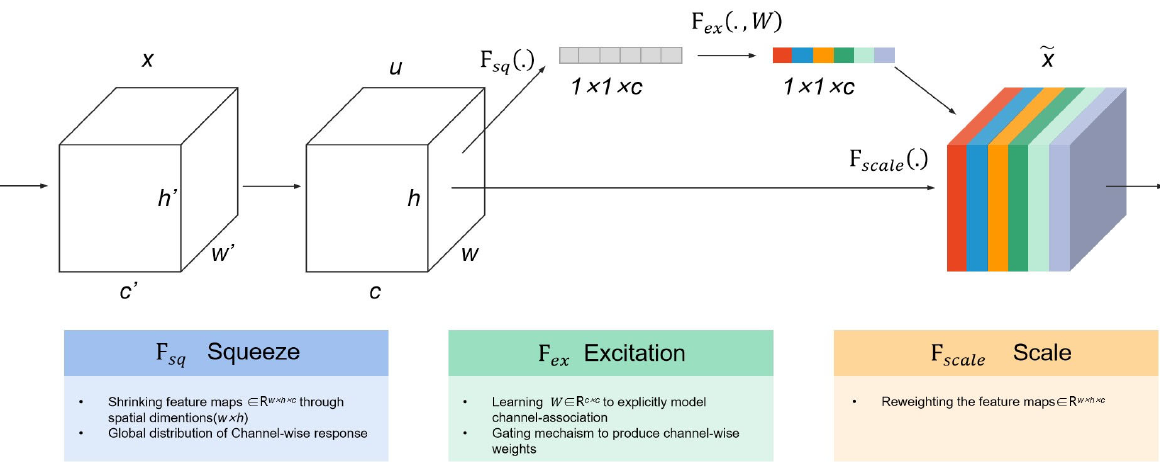
Figure 9. The illustration of squeeze and excitation (SE) blocks.